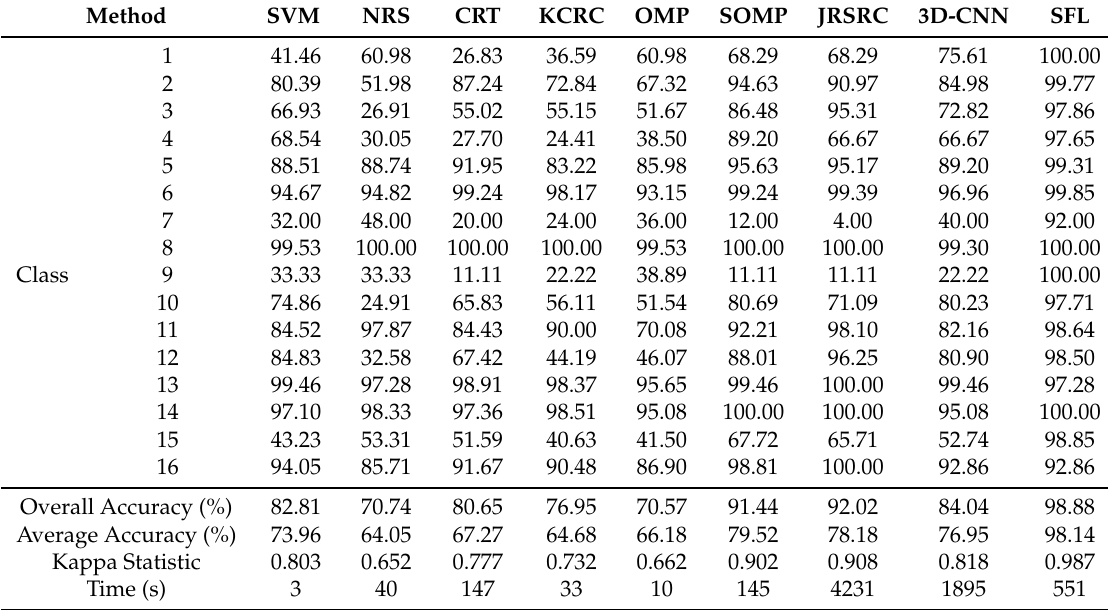
Table 7. Overall Accuracy, Average Accuracy, Kappa Statistic and Time of the Indian Pines data set when using the compared methods and the proposed methods.